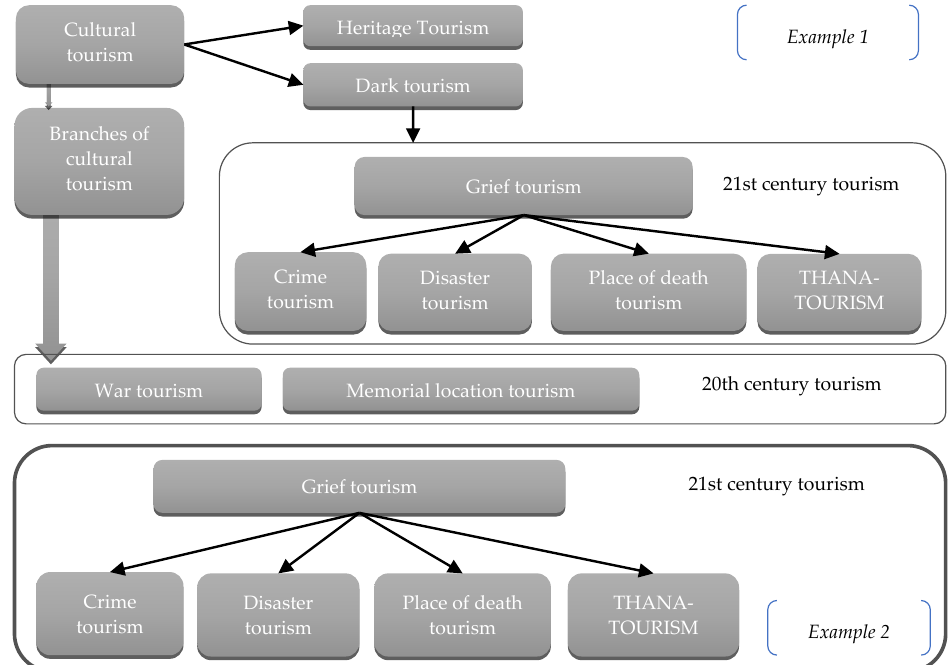
Figure 4. The development of Dark Tourism .